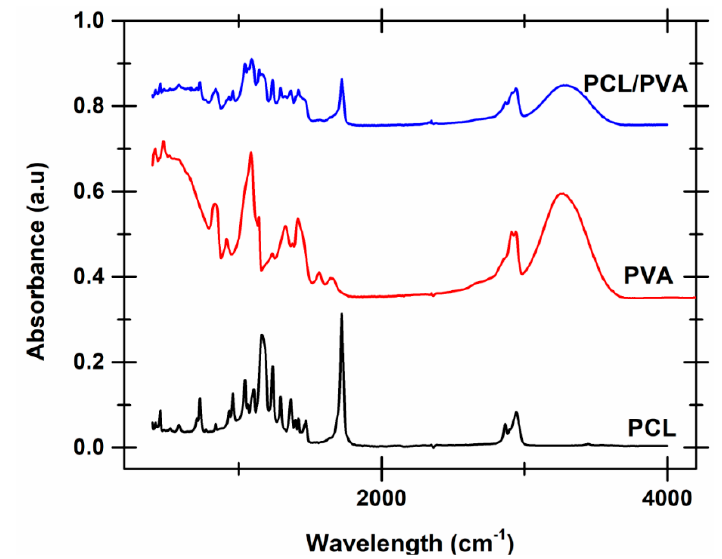
Figure 3. FTIR scans recorded for neat PVA and PVA reinforced with PCL fibers. The FTIR scans of neat PCL is also shown in the plot for comparison purposes.